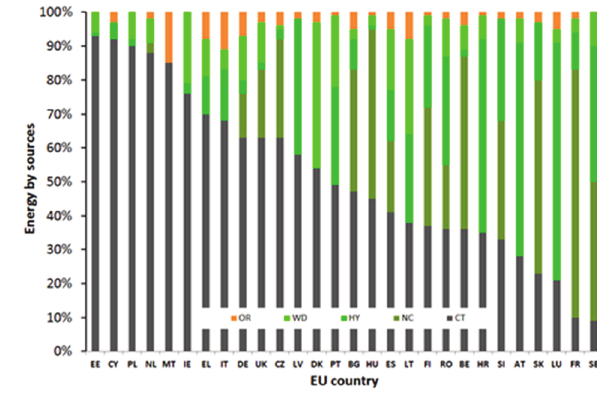
Fig. 1. Energy by sources in some countries in Europe. (CT – conventional thermal, NC – nuclear, HY – hydro, WD – wind, OR- other resources, based on